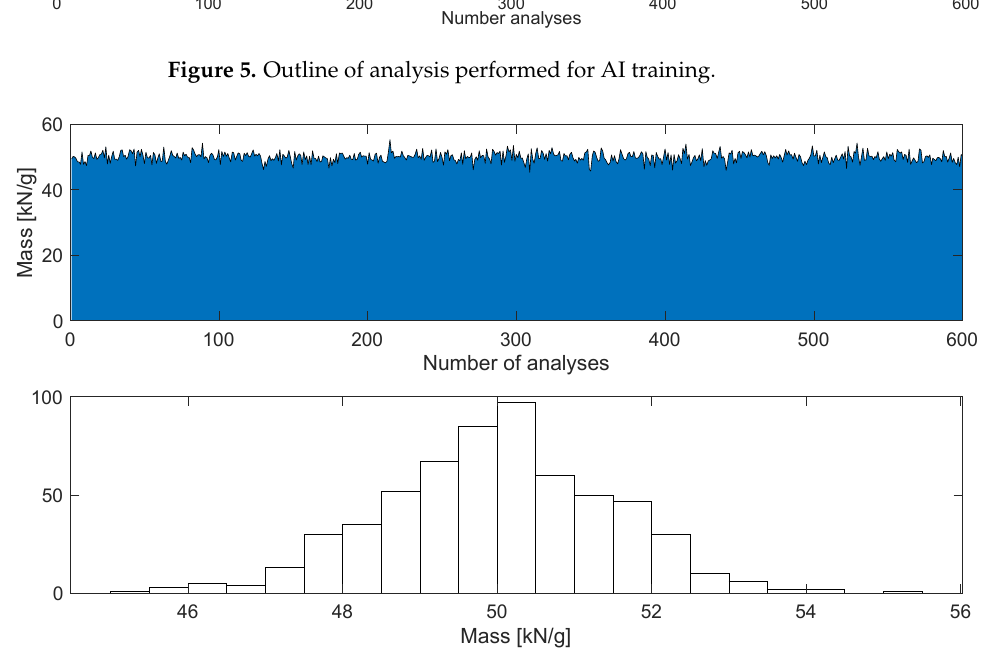
Figure 6. Stochastic variation in mass.